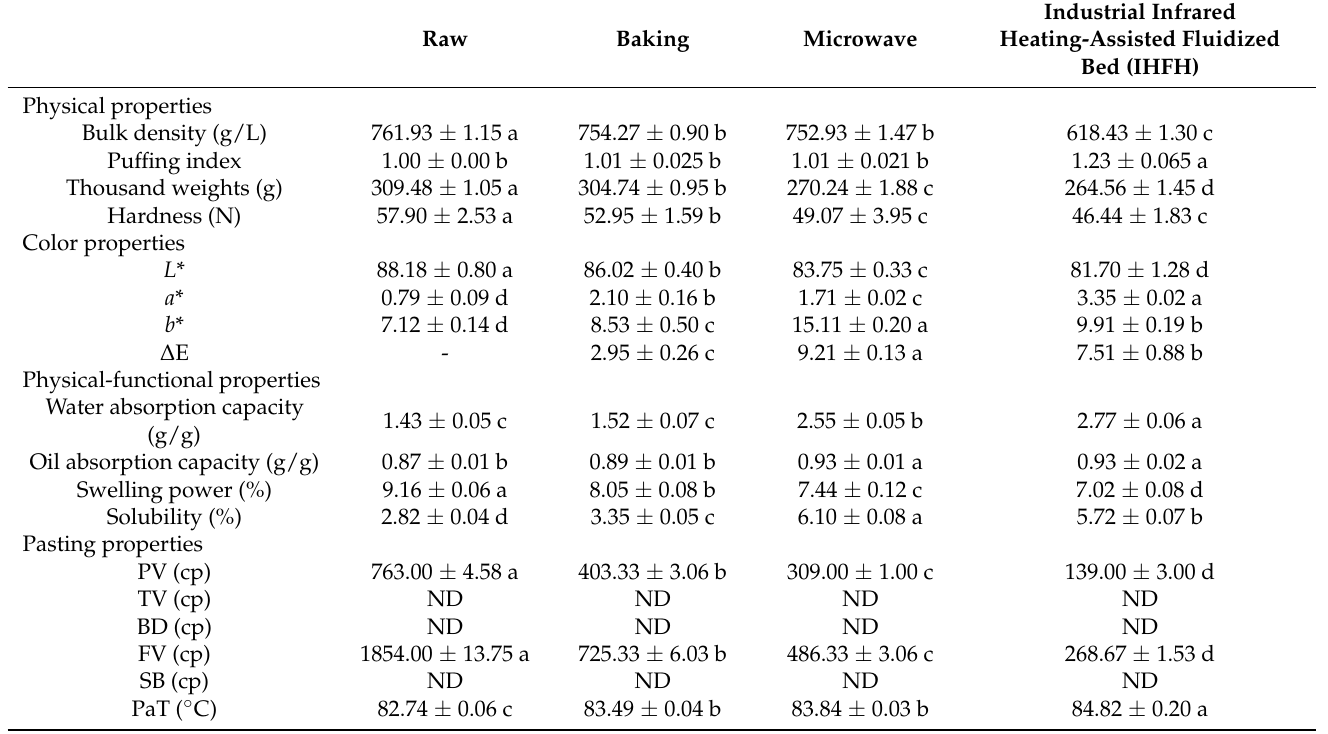
Table 1. Effect of thermal treatments on the physical, color, physical-functional, and pasting properties of roasted Euryale ferox seed (EFS) flour.